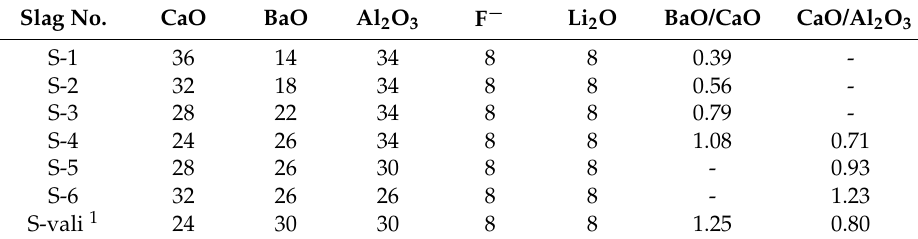
Table 1. Chemical composition of experimental slags (wt %). Slag